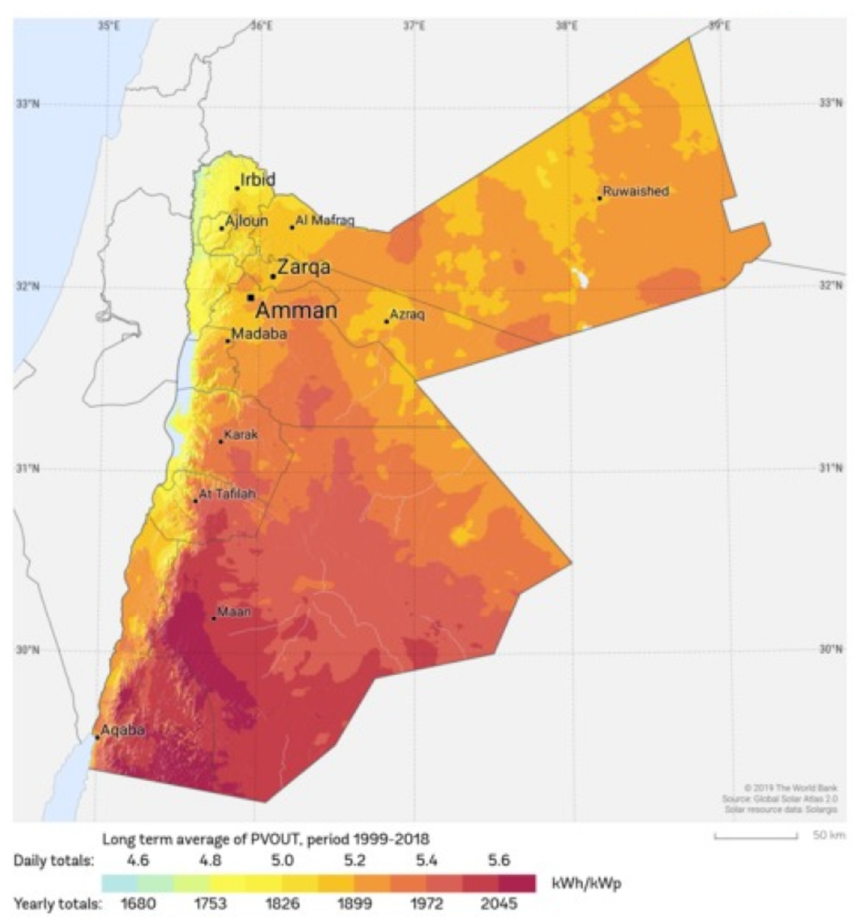
Figure 1. Jordan Photovoltaic Power Potential [20].